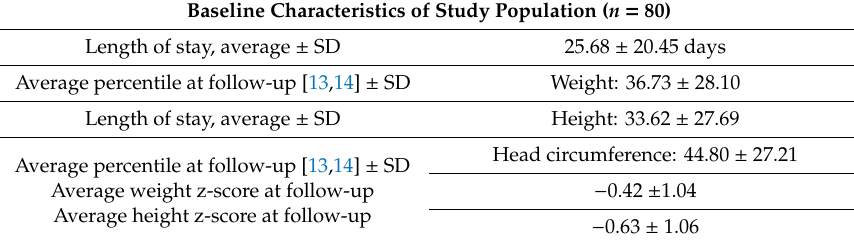
( c ) Figure 1. ( a ) Distributions of weight percentiles at birth and at follow-up; ( b ) distributions of length/height percentiles at birth and at follow-up; ( c ) distributions of head circumference percentiles at birth and at follow-up. Significant individual positive correlations between percentiles of length and head circumference at birth and of height and head circumference at follow-up were detected, respectively with a moderate and a weak correlation Figure 2, with a p -value of 0.004 for length/height and of 0.046 for head circumference. An increase of one percentile of length at birth determined an increase of 0.352 percentiles of height at follow-up, while an increase of one percentile of head circumference at birth determined an increase of 0.214 percentiles of head circumference at follow-up.